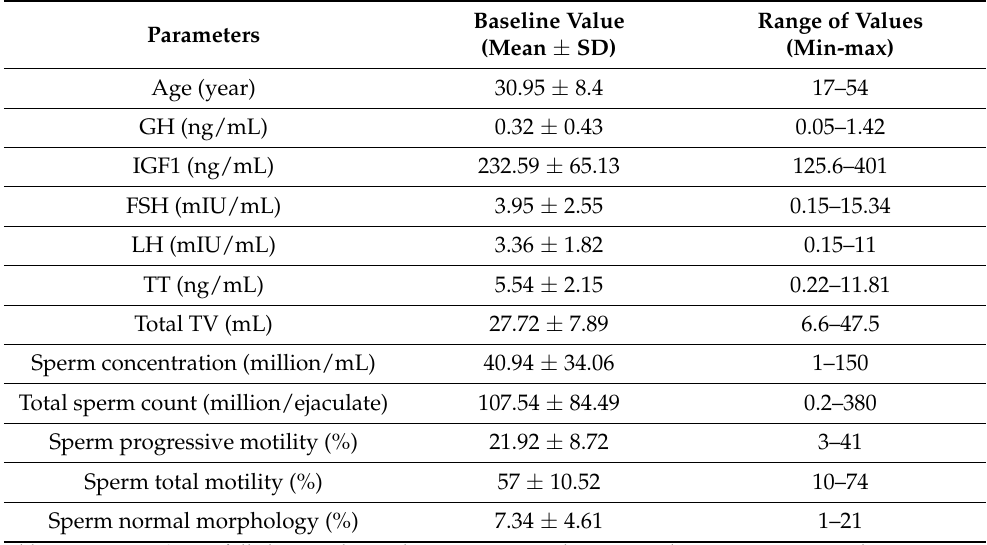
Table 2. Range and baseline values of the entire